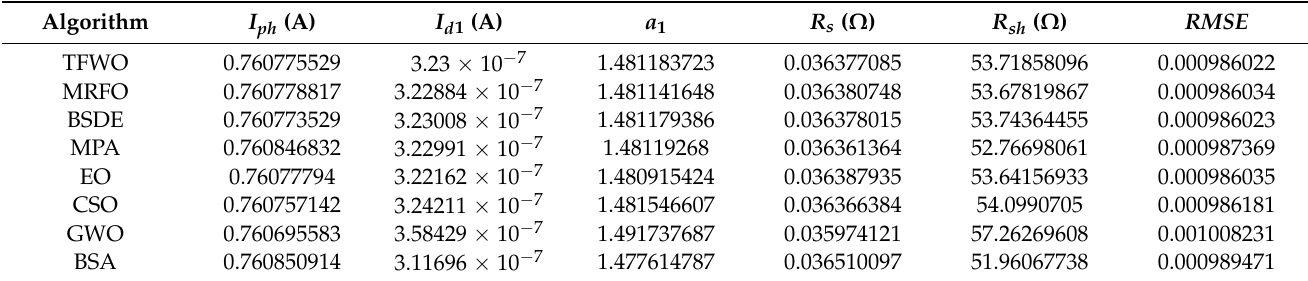
Table 3. The parameters extracted for R.T.C. France SDM at the best root mean square error ( RMSE ).